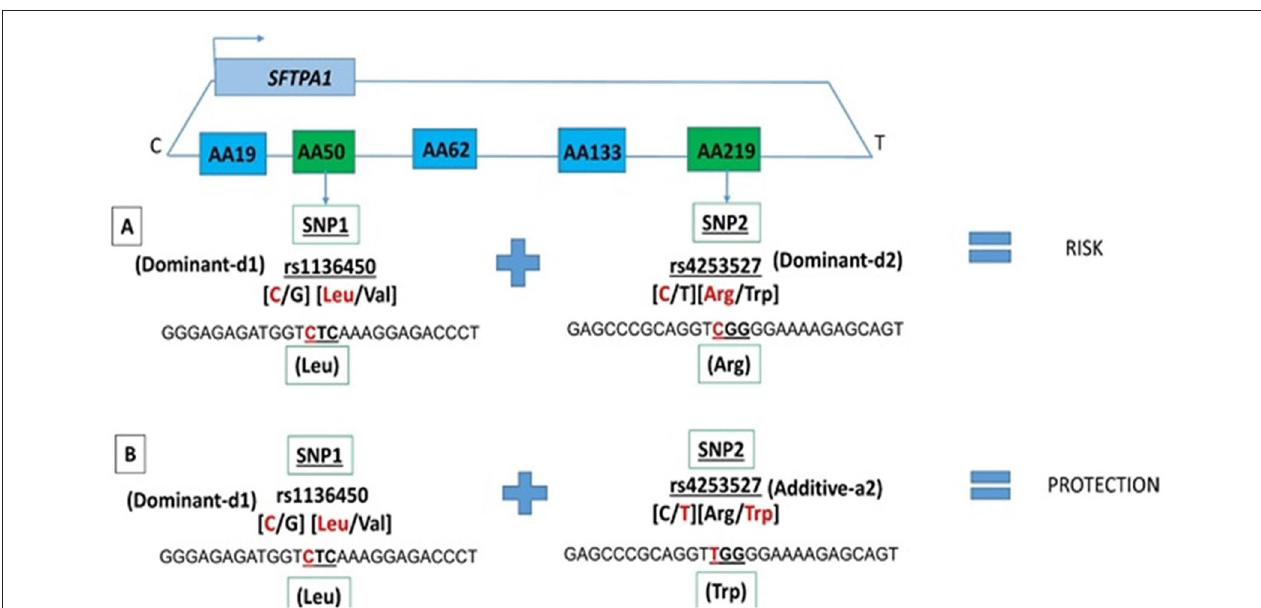
FIGURE 1 | SFTPA1 intragenic two SNP interactions and RDS susceptibility. It shows the schematic presentation of SFTPA1 on the top and the arrow depicts the transcriptional orientation. The relative location of SNPs are shown from centromere (C) to telomere (T) and each box represents the amino acid number that includes the particular SNP. For example, AA50 denotes the rs1136450 SNP and AA219 denotes the rs4253527 SNP. The amino acid numbering is based on the precursor molecule and thus includes the signal peptide ( 56). In this two SNP intragenic interaction, underneath the green boxes are the SNP ID and the actual SNPs involved. (A) The dominant effect, dl of SNP1, is highlighted by red, as noted for the rs1134650C variant that codes for leucine. This interacts with the dominant effect of SNP2, rs4253527C variant that codes for arginine (in red) and increases risk of RDS. (B) The dominant effect, dl of SNP1, is highlighted by red and this SNP interacts with the additive effect of SNP2 rs4253527T variant that codes for tryptophan and this interaction is protective for RDS.